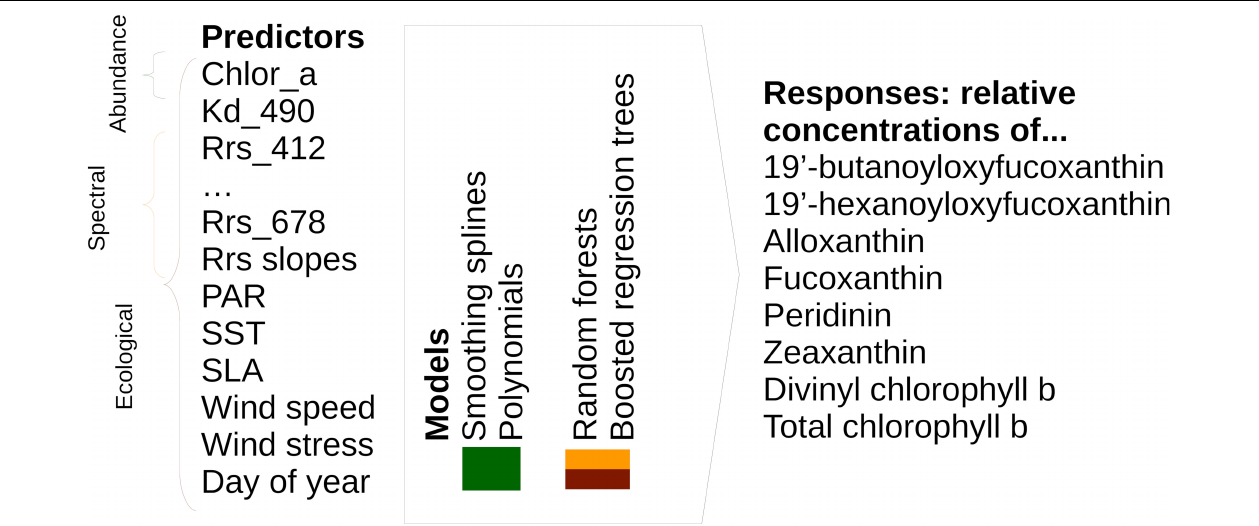
FIGURE 1 | Overview of model types, including predictors and responses, included in this study. Please note that we tested spectral and ecological models using both raw Rrs and Rrs normalized as described in Section “Statistical Models and Predictors.”